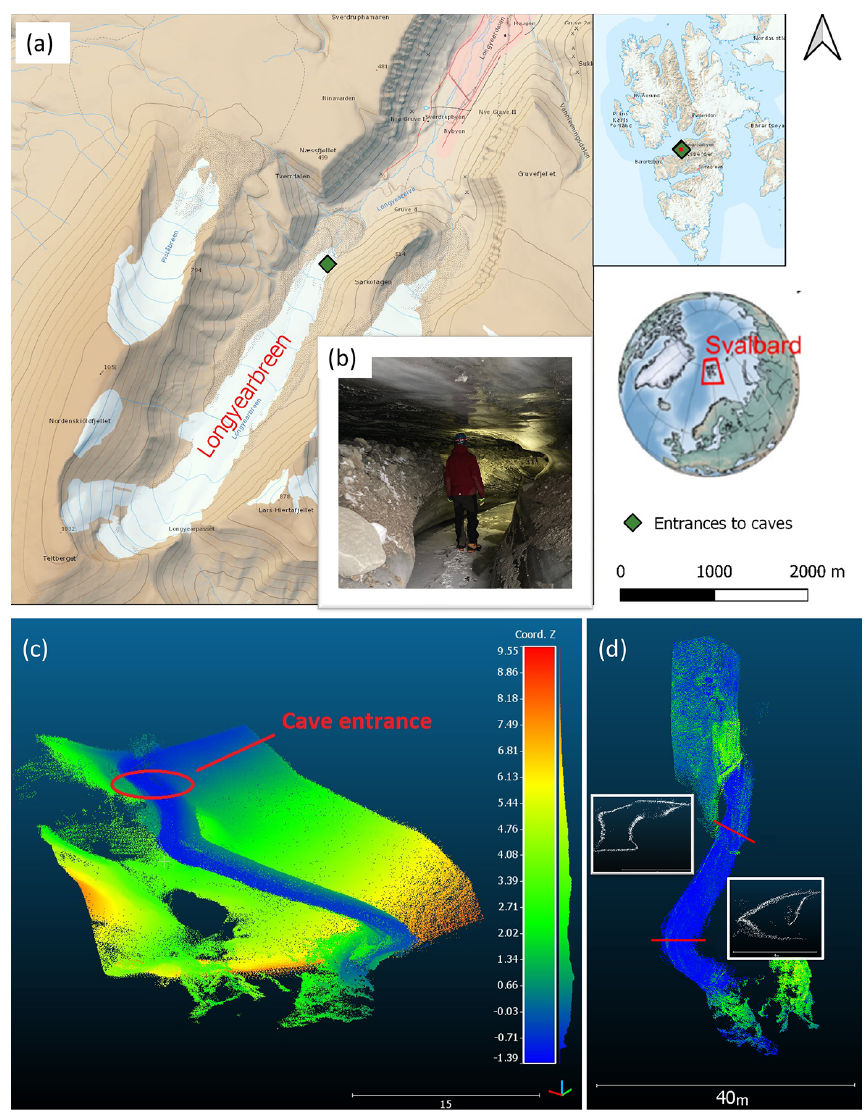
Figure 7. Resulting point cloud visualizations of the glacier cave on Longyearbreen (a) . Panel (b) shows an image of the entrance and (c) a view from below the point cloud with the glacier cave and the glacier surface. Panel (d) shows the extracted cave (nadir view) with two cross sections with the same color bar as in (c) . The maps are retrieved from https://toposvalbard.npolar.no (last access: 30 July